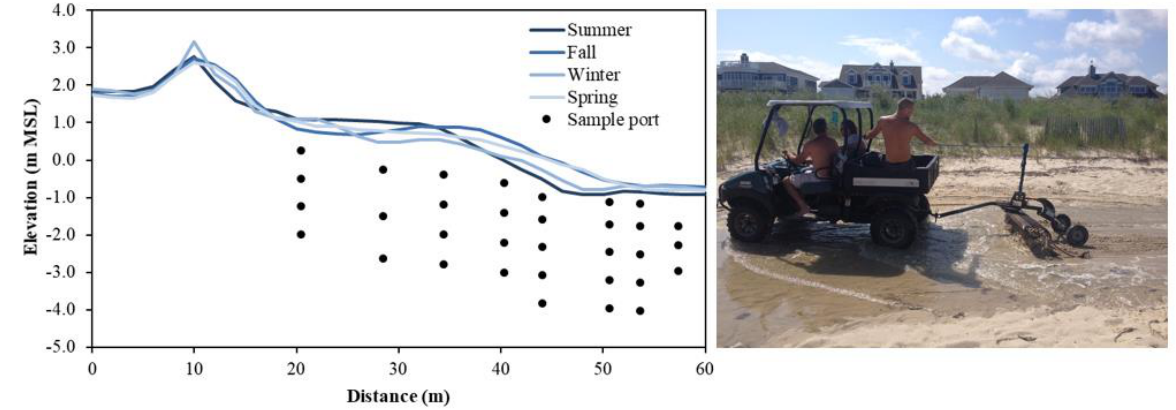
Figure 3. Left: Seasonal beach profile evolution at Cape Shores, DE, USA and example sampling port locations. Topo- graphic lows that form in the backshore (x = ~ 30 m) during winter can allow seawater to pool and serve as a continuous source of saltwater to the aquifer. Right: Beaches used recreationally may be subject to beach management practices, such as raking, artificially altering beach topography.